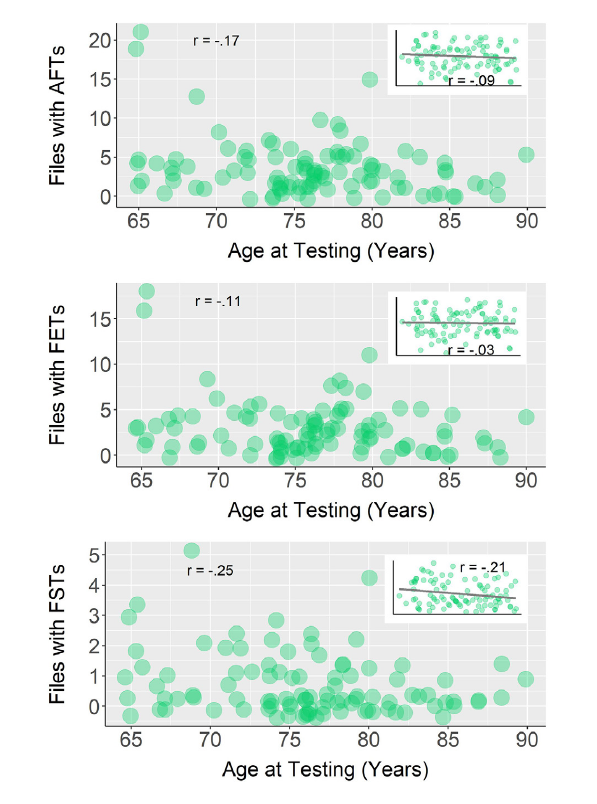
FIGURE 3 | Correlations between age and (A) sound files with autobiographical future thoughts (AFTs), (B) sound files with future episodic thoughts (FETs), and (C) sound files with future semantic thoughts (FSTs). Raw data and correlation coefficients of the bivariate Spearman correlations are represented in the larger plots. The partial Spearman correlations are shown in the small plots with regression lines. For all three partial correlations, we used a covariate of the number of sound files where participants were engaged in